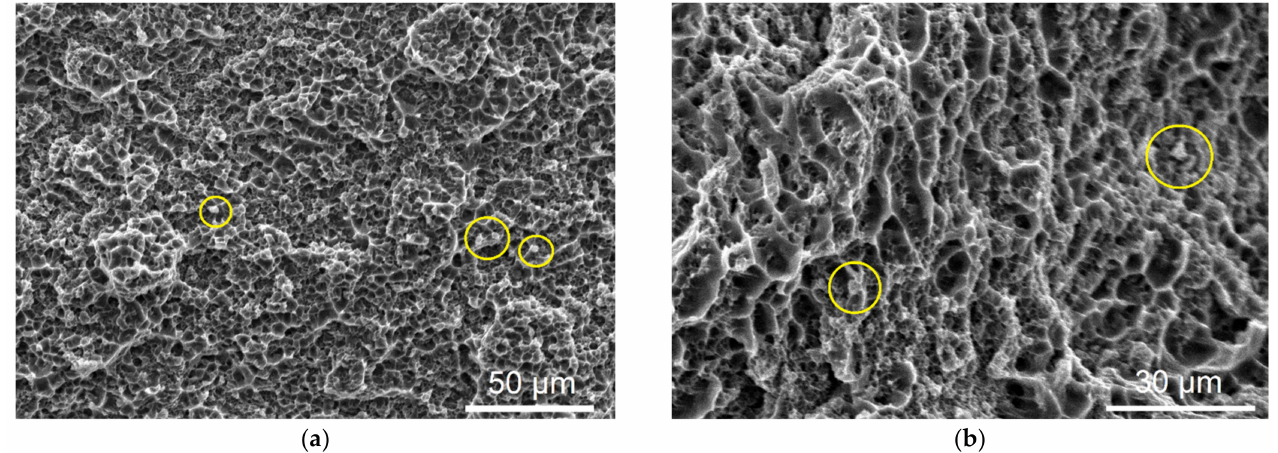
Figure 15. Fracture surface at magnification ( a ) × 500 and ( b ) × 1000.